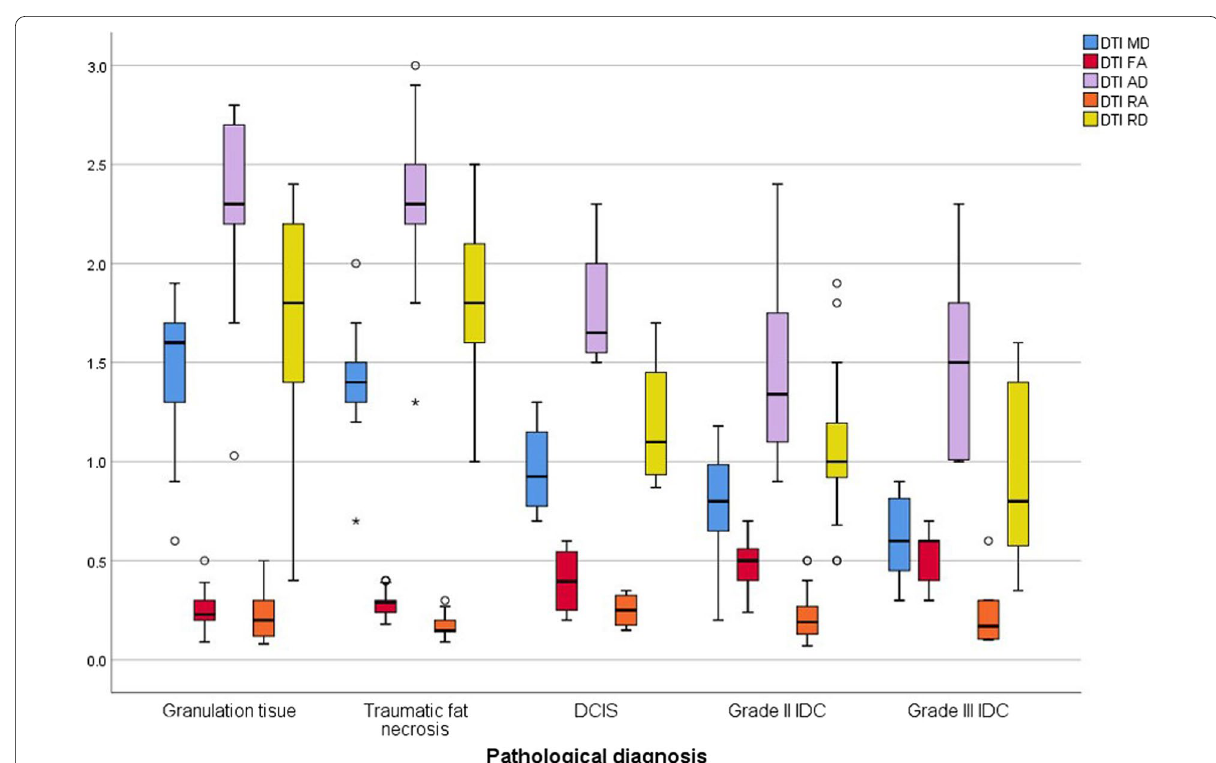
Fig. 4 Box‑plot for DTI parameters showing that the median MD, AD, and RD values were higher in DCIS than granulation tissue and traumatic fat necrosis. However, they were lower in DCIS than in grade II and grade III IDC. The median FA values were significantly higher in both grade II and grade III IDC versus both granulation tissue and traumatic fat